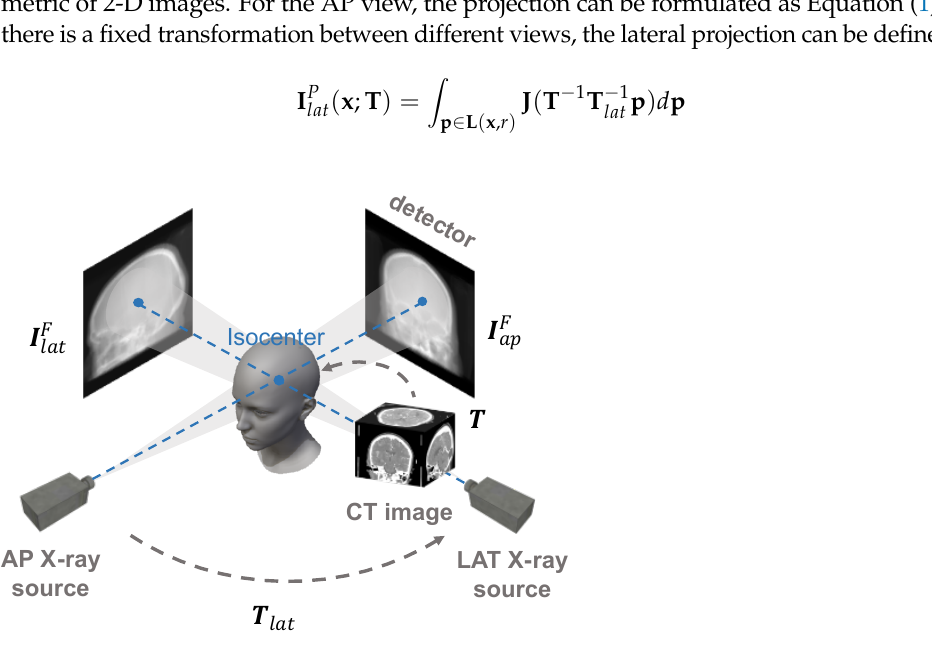
Figure 2. The X-ray imaging model of mult-view 2-D/3-D rigid registration. The goal of registration is to solve the transformation T